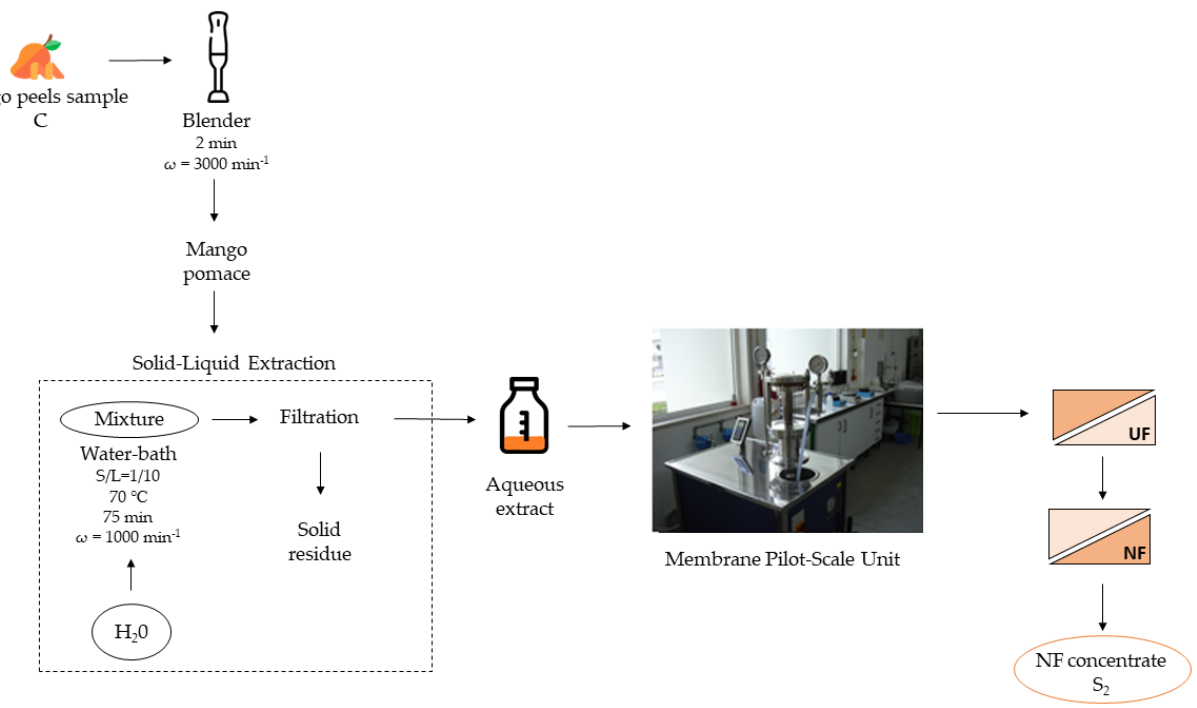
Figure 2. Co-substrate origin (adapted from [23]). Experimental conditions—UF: membranes with a cut-o ff of 25 kDa; Δ P = 2.0 bar; v = 0.91 m s − 1 , at room temperature. NF: membranes with a cut-o ff of 130 Da; Δ P = 20.0 bar; v = 0.91 m s − 1 ; at room temperature.